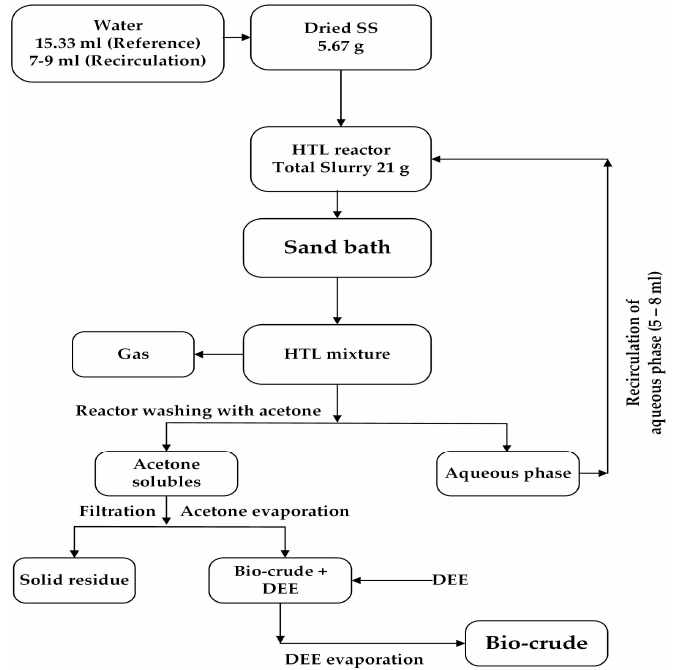
Figure 2. Schematic diagram of the HTL process with the recycling of the aqueous phase.